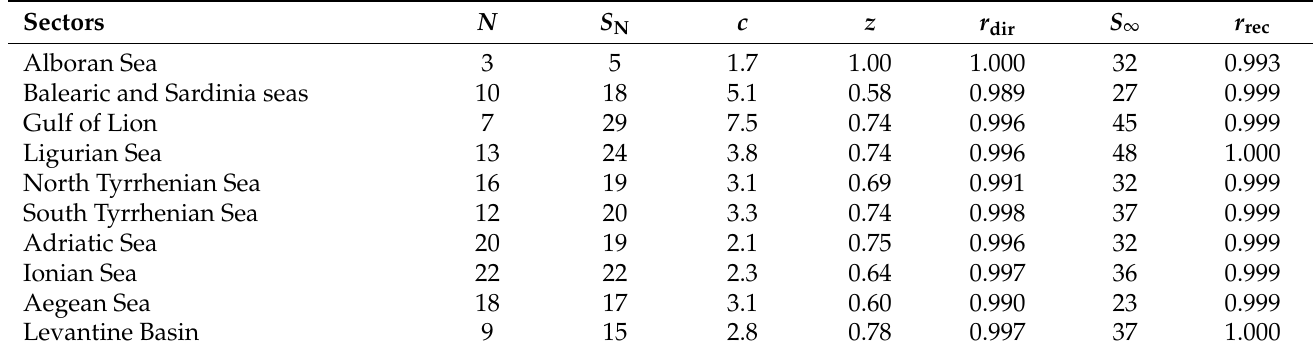
Table 2. Summary of the main parameters and coefficients of the species/caves curves.